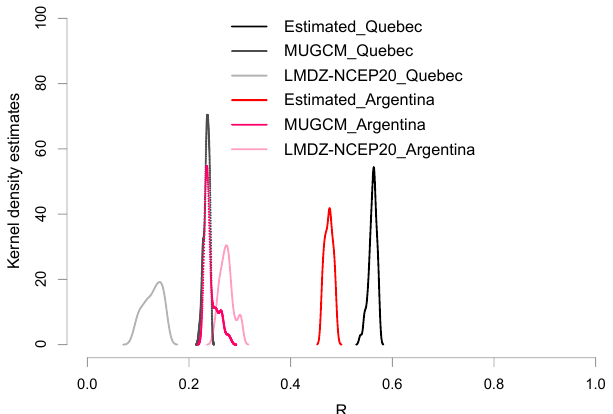
Figure 4. Density distributions of the coefficient of correlation ( R ) between observed and simulated δ 18 O TR chronologies in Québec and Argentina when the simulations are based on δ 18 O P series es- timated by the regression model or from the MUGCM and LMDZ- NCEP20 models.